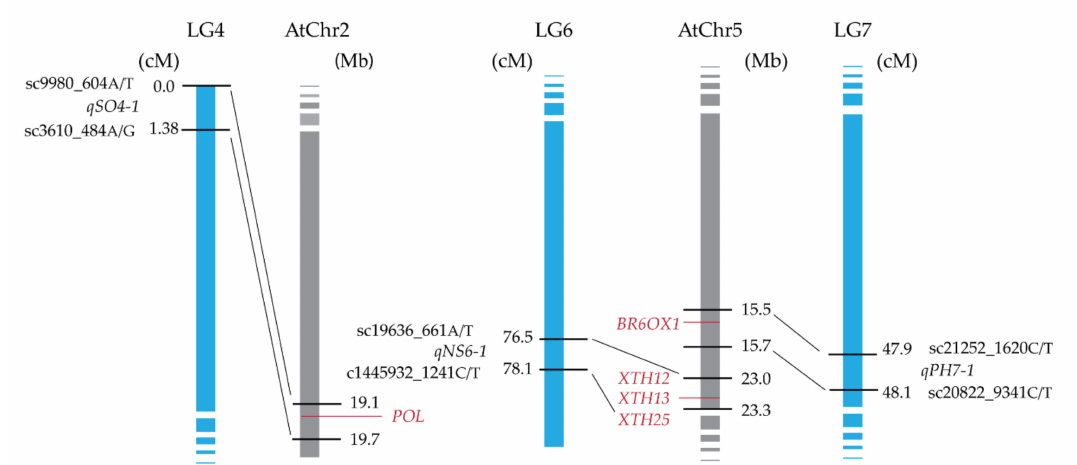
Figure 3. Candidate genes for the QTLs, controlling stem growth orientation ( qSO4-1 ), number of stems per plant ( qNS6-1 ), and plant height ( qPH7-1 ) in field cress. A comparison of the homologous regions between flanking markers from L. campestre linkage groups (LGs) and A. thaliana chromosomes (AtChr2 and AtChr5). The position of flanking markers is given in cM on L. campestre LGs and in Mbp on A. thaliana chromosomes. A. thaliana homologous genes of interest are shown in